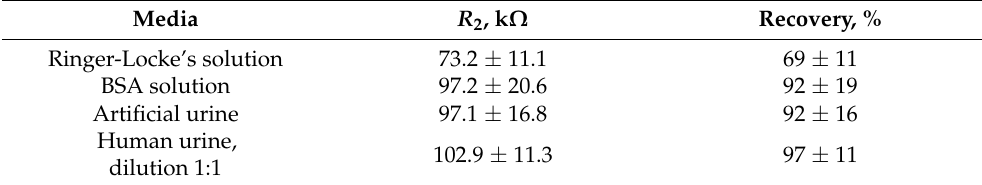
Table 2. Determination of 1 pM idarubicin in spiked samples of various media mimicking serum, blood plasma, in artificial and human urine by electrochemical impedance spectroscopy. Mean ± S.D. for six individual sensors.